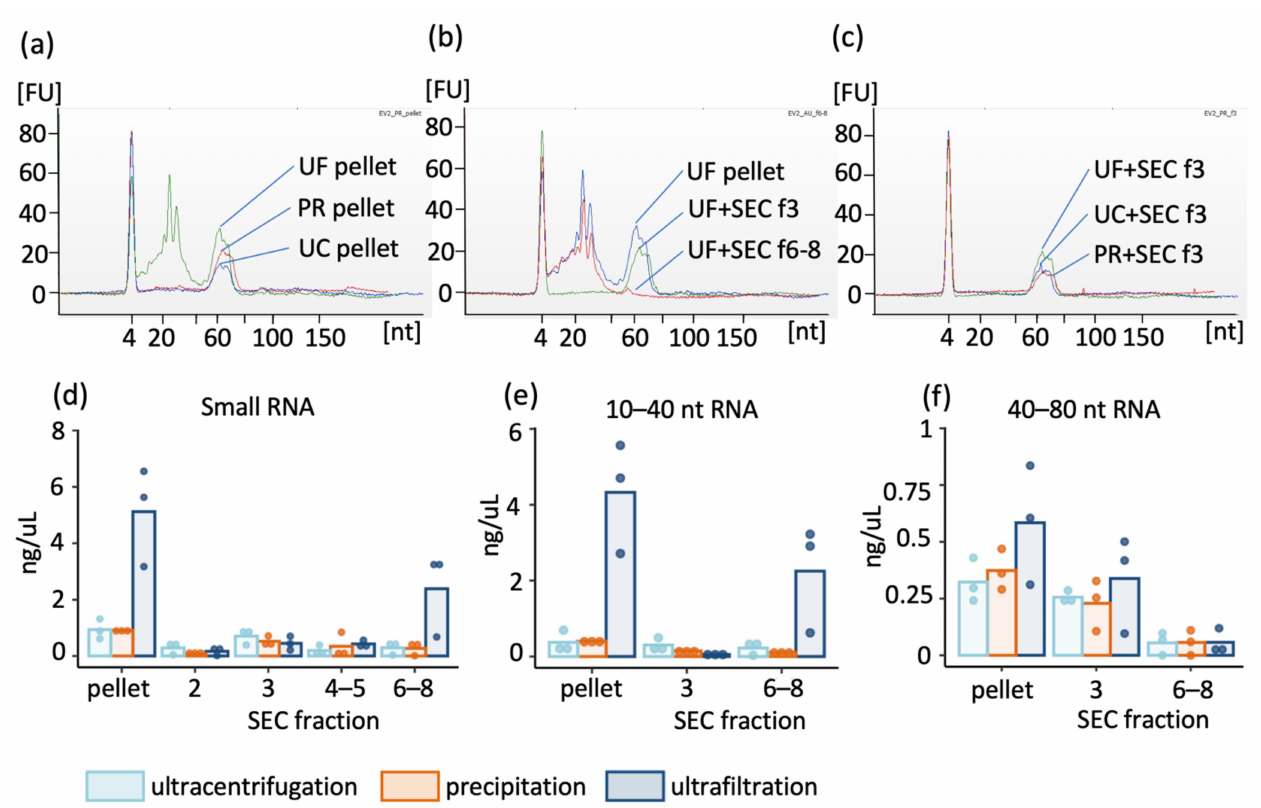
Figure 4. Small RNA profiles of extracellular vesicles (EV) prepared by ultrafiltration (UF), precipitation (PR) and ultra- centrifugation (UC) both before and after size-exclusion chromatography (SEC). Representative profiles of samples from individual round of: ( a ) the pellets before SEC purification, ( b ) UF profile before SEC, EV containing SEC-fraction 3 and non-vesicular protein fractions 6–8, ( c ) EV containing SEC fraction 3 from all three methods. RNA concentration from all three rounds showing: ( d ) Total small RNA concentration in measured fractions, ( e ) 10–40 nt sized RNA in UF pellets and SEC fractions 3 (EVs) and 6–8 (non-vesicular proteins), ( f ) 40–80 nt sized RNA in UF pellets and SEC fractions 3 and 6–8. Data are presented as individual values and